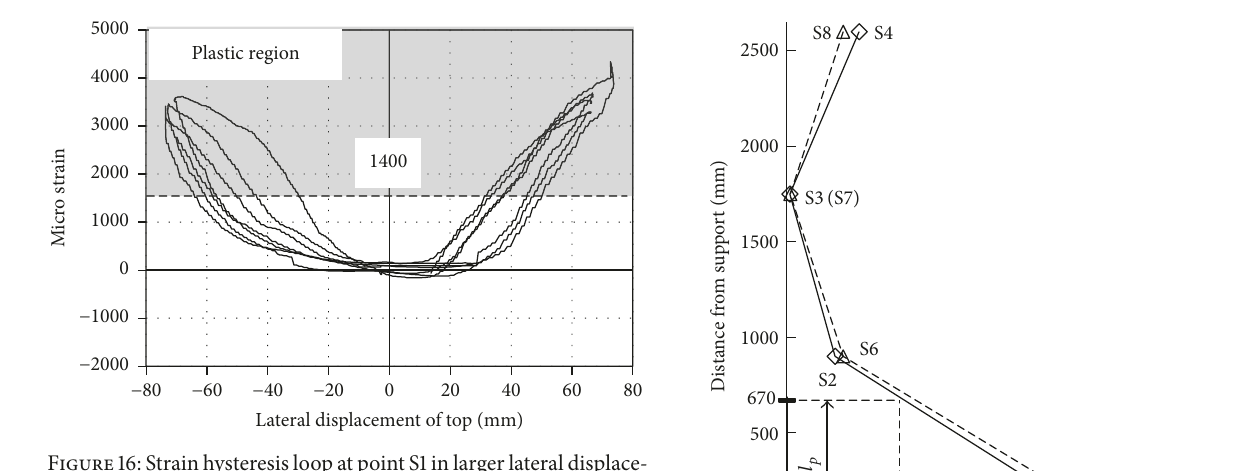
Figure 16: Strain hysteresis loop at point S1 in larger lateral displace- ments.